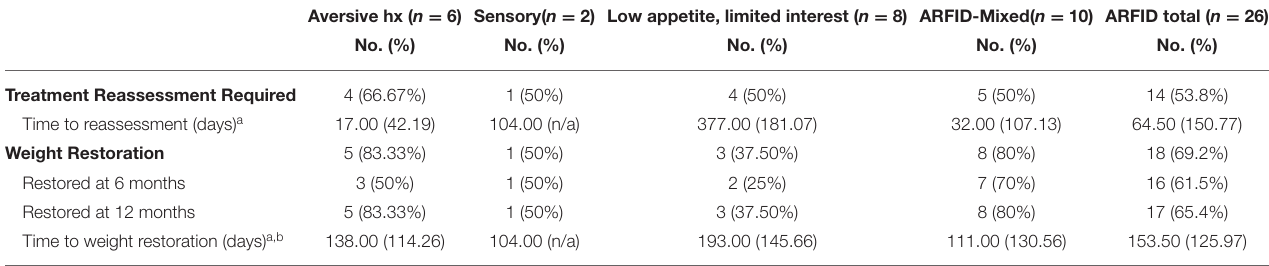
TABLE 4 | Treatment trajectories of pediatric ARFID patients ( n = 26) admitted to a specialized pilot